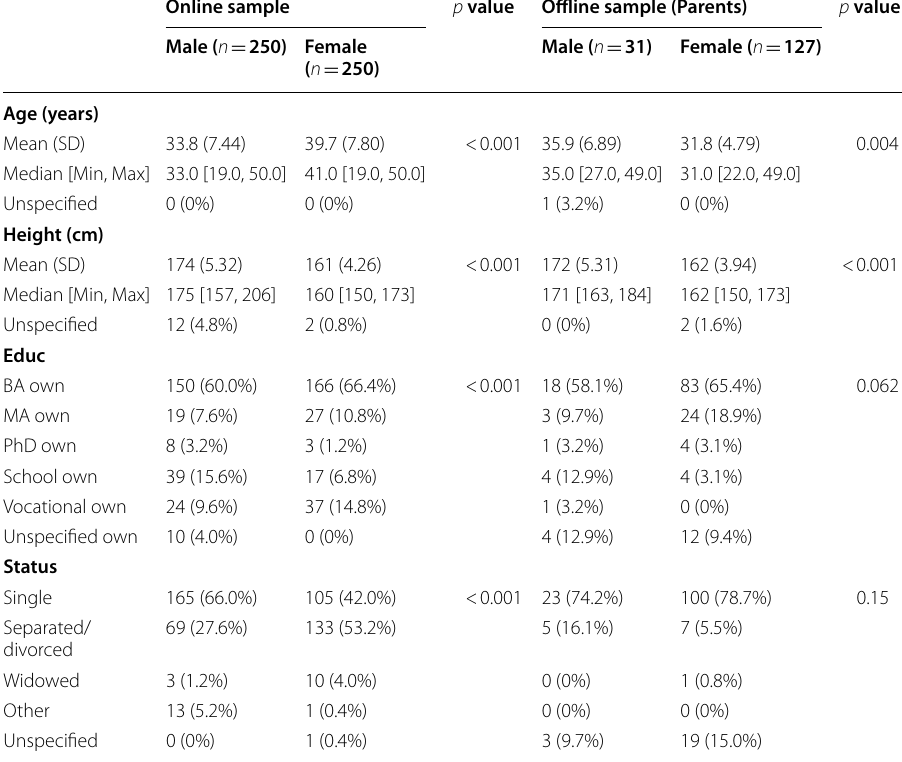
Table 1 Summary of Own Attributes between males and females within the online and offline